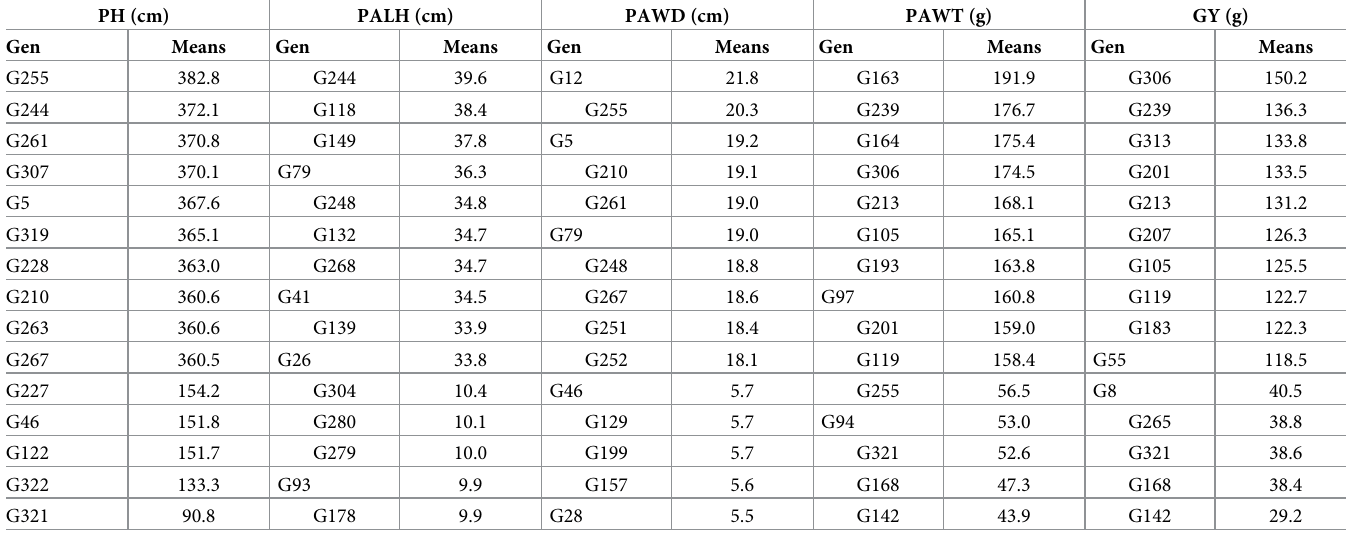
Gen = Genotype, PH = Plant height, PALH = Panicle length, PAWD = Panicle width, PAWT: Panicle weight, GY: Grain yield. Note : The first ten accessions in each “Gen” columns are the top ten whereas the last five accessions are the bottom five for the corresponding traits.